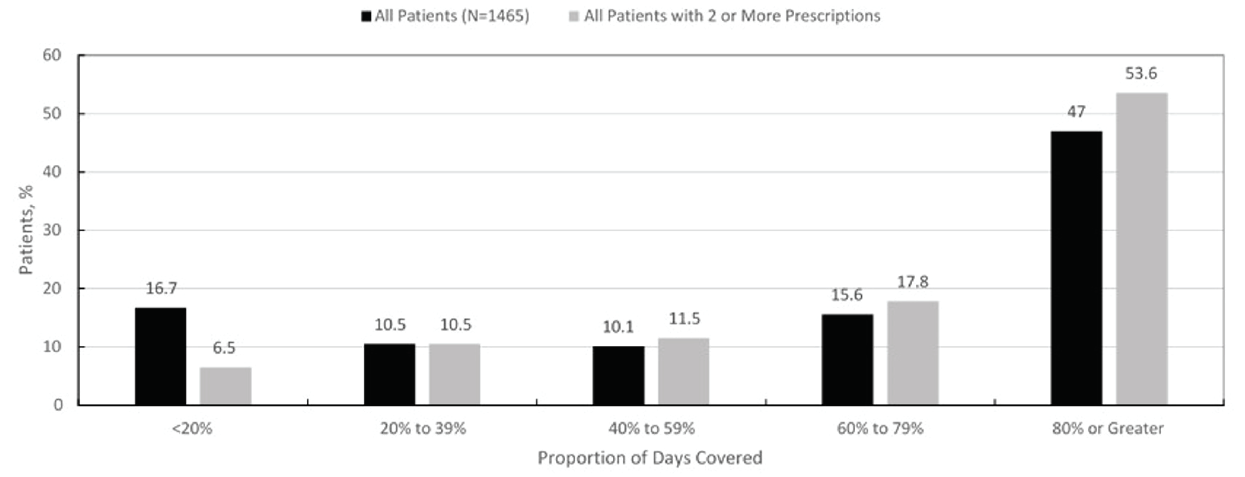
Figure 3. Treatment Adherence During the 12-month Post-index Period